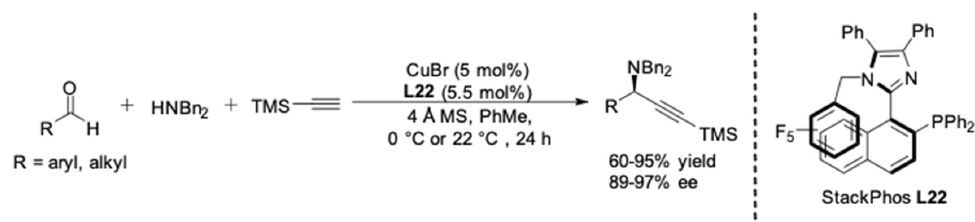
Figure 22. Enantioselective A 3 -coupling employing L22 .